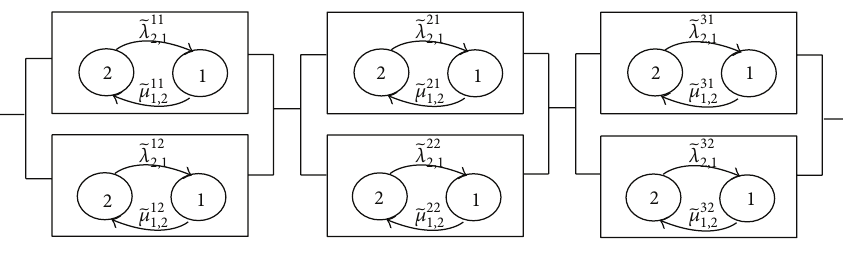
Figure 5: Multistate system and state diagrams for RMSS.